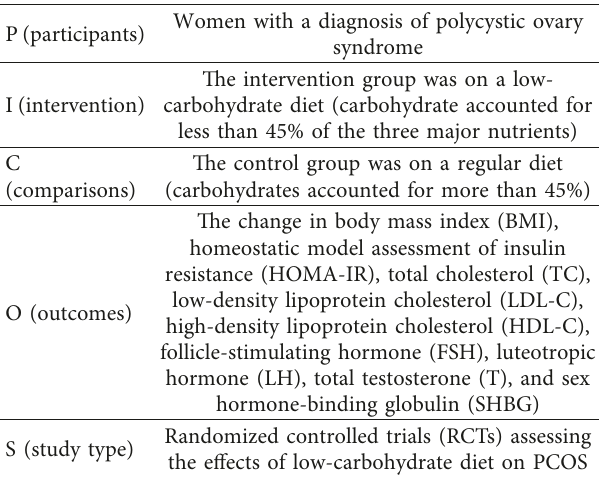
Table 1: Inclusion